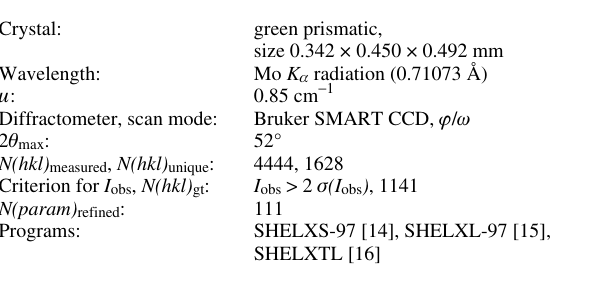
Table 1. Data collection and handling.